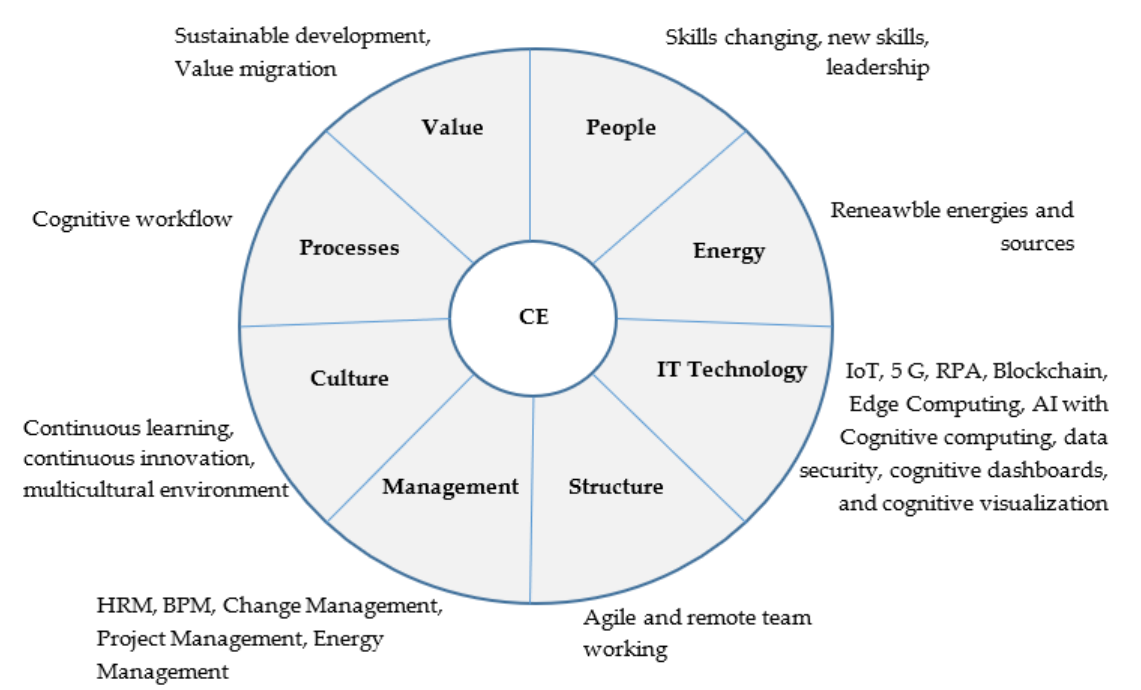
Figure 9. A conceptual framework of the CE core transformation perspectives.